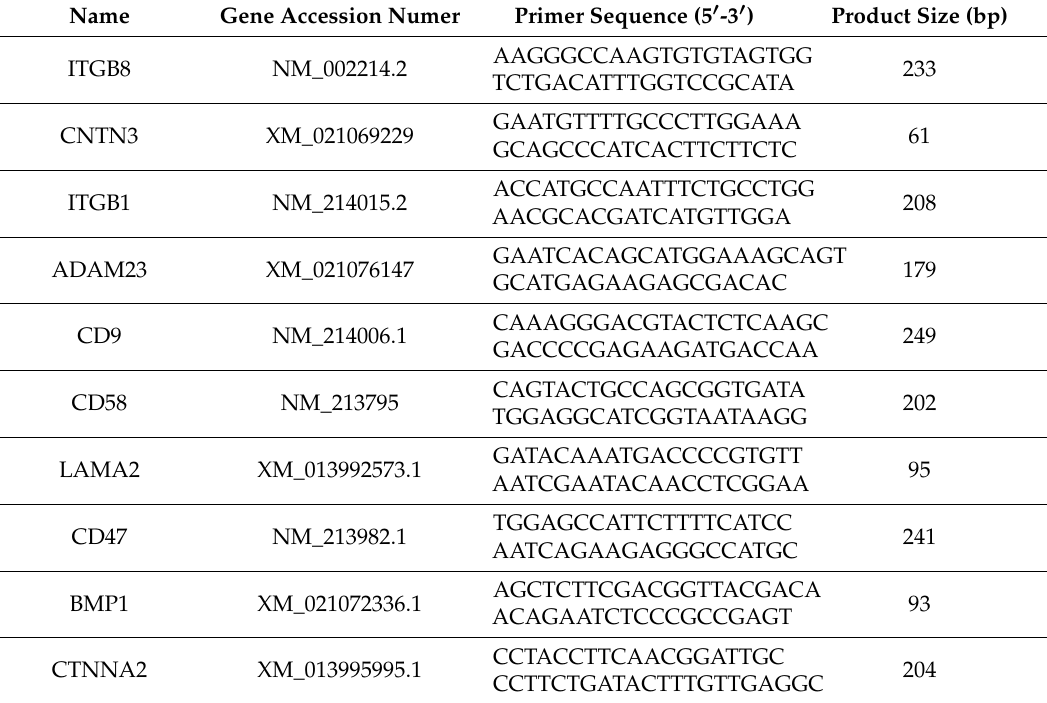
Table 2. Oligonucleotide sequences used for RT-qPCR